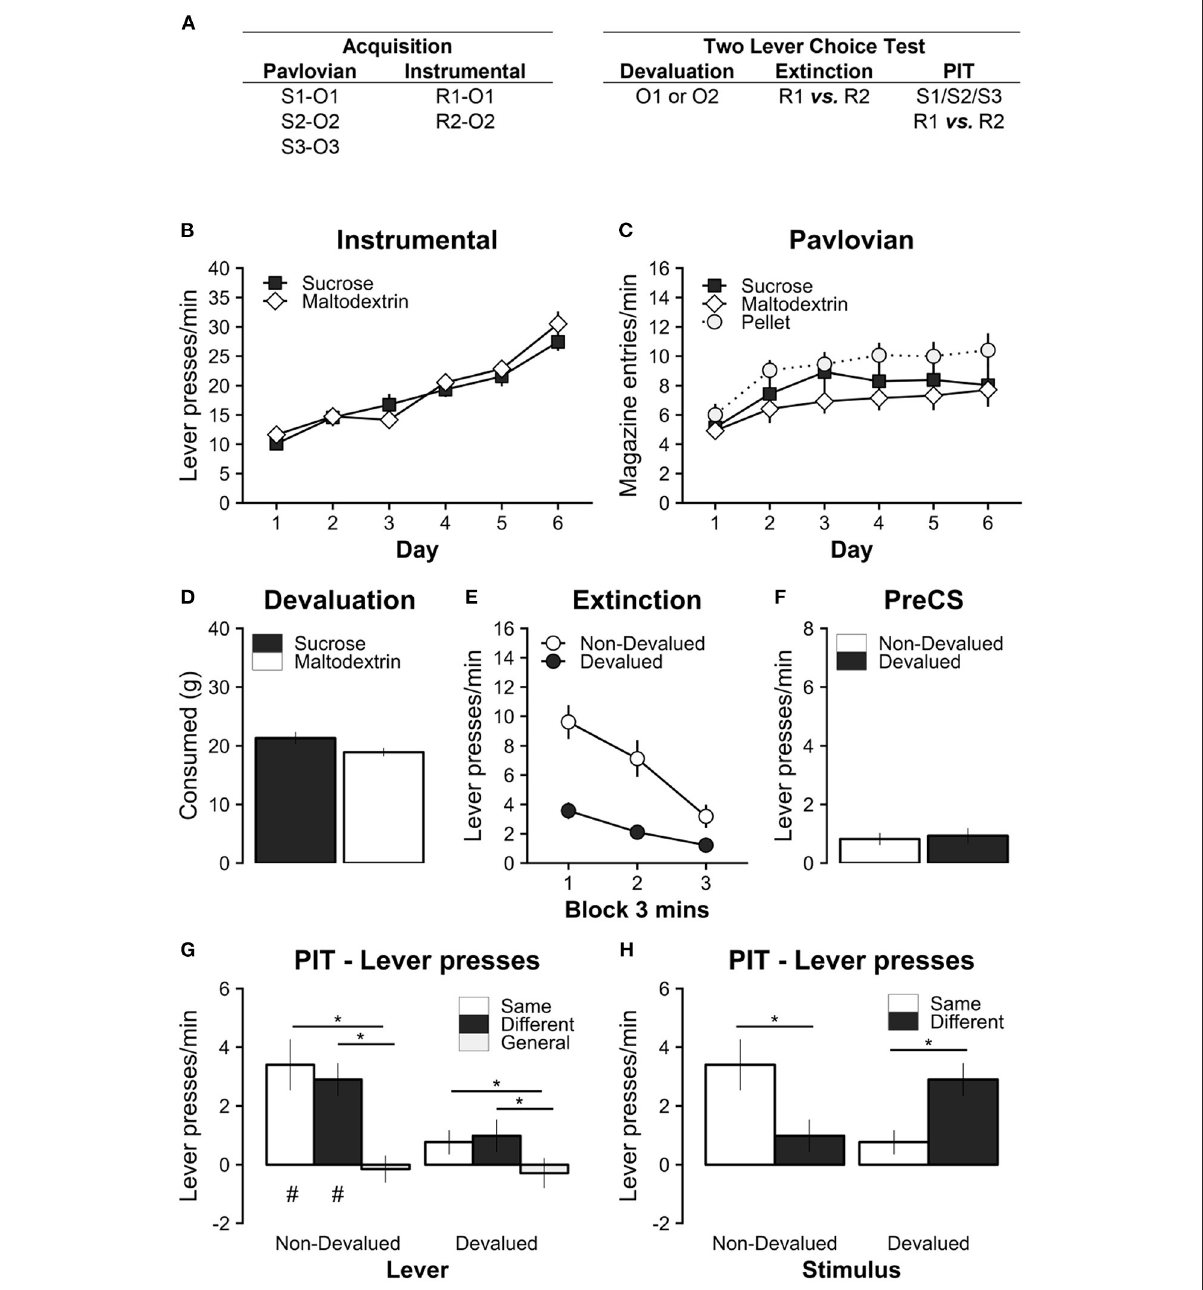
FIGURE1 Experiment 1 tested the effect of outcome devaluation by sensory-specific satiety on specific PIT in a two-lever choice test. (A) Experimental design; S1/S2/S3: clicker, tone, and noise stimuli (counterbalanced); R1/R2: left and right lever press actions (counterbalanced); O1/O2: sucrose and maltodextrin liquid reinforcer outcomes (counterbalanced); O3: pellet reinforcer outcome. (B) All rats learned to perform the left and right lever responses for the sucrose and maltodextrin liquid reinforcers. (C) All rats learned that the Pavlovian stimuli uniquely predicted the sucrose, maltodextrin, and pellet outcomes. (D) During the 1-h specific satiety devaluation session, rats consumed a substantial amount of the reinforcer, but consumed slightly more when the reinforcer was sucrose. (E) Outcome devaluation successfully reduced the rate of lever pressing on the lever associated with the devalued outcome during the extinction period with both levers present. (F) Baseline responding during the PIT test was similar on the devalued and non-devalued levers. (G) Outcome devaluation abolished specific PIT when separating responses on the non-devalued (Left) and devalued (Right) levers. (H) Outcome devaluation reversed specific PIT when separating responses during the non-devalued (Left) and devalued (Right) stimuli. Note that the same data are presented in (G) and (H) . * Significant simple effects. p < 0.05. # Significant responding above baseline, p < 0.05. Full analysis details in main text. Data are presented as mean ±